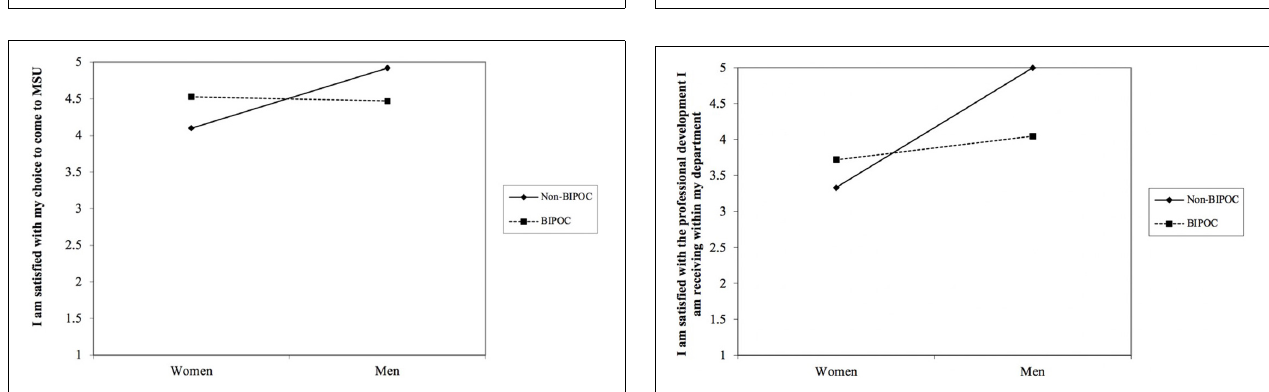
FIGURE 2 | Gender interacting with BIPOC to predict MSU environment (overall measure).